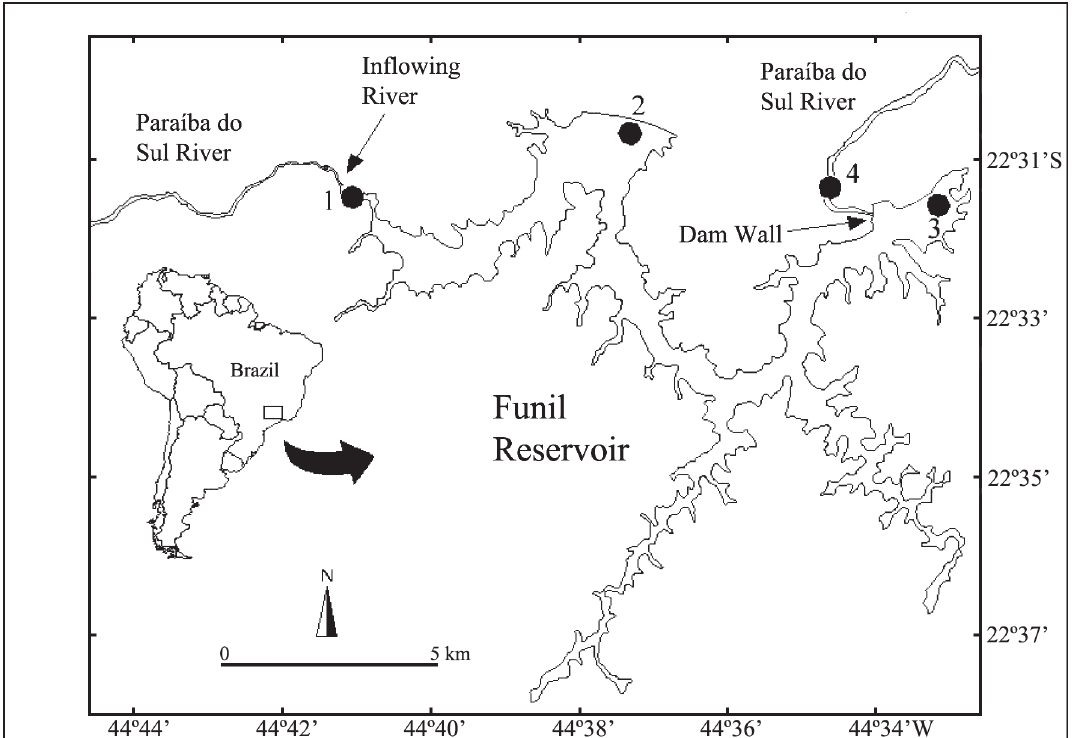
Fig. 1. Paraíba do Sul River - Funil Reservoir system. The four sampled zones are shown (1 = Zone 1; 2 = Zone 2; 3 = Zone 3, and 4 = Zone